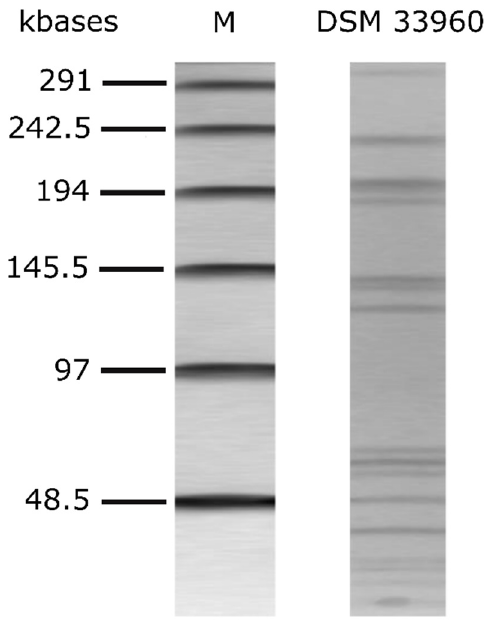
Figure 1. PFGE profiles of Asc I-digested genomic DNA of L. rhamnsous CA15 (DSM 33960) strain. M: Lambda PFG marker (New England Biolabs, Inc., Ipswich, MA, USA).